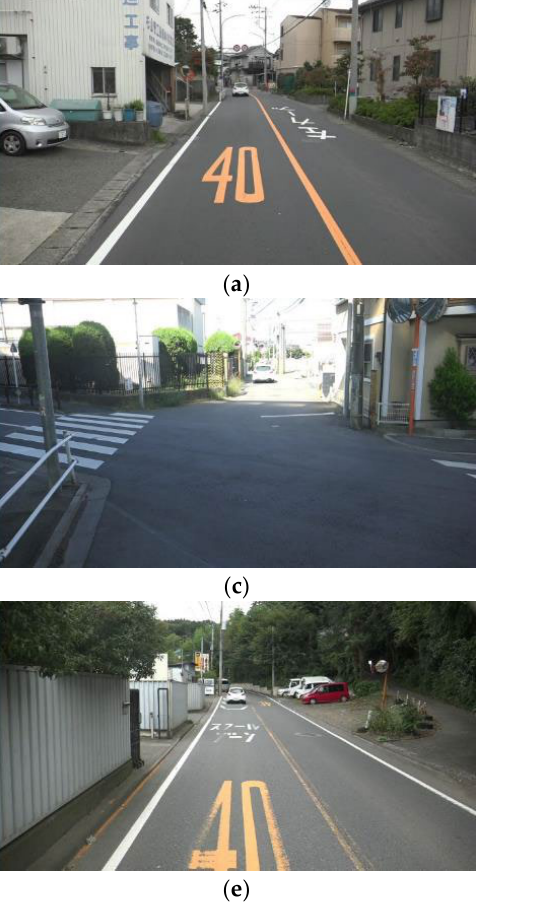
Figure 1. Some examples of road markings on road surfaces: ( a ) white solid, maximum speed limit 40, yellow solid, and left-curve notice (ordinary); ( b ) stop notice and stop line (shadow); ( c ) pedestrian crossing and stop line (dazzle light); ( d ) white solid, yellow solid, turn-right notice, and straight notice (occlusion); ( e ) white solid, maximum speed limit 40, school-zone notice, slow-down marking, and yellow solid (deteriorated road markings); ( f ) white solid, slow-down notice, stop notice, stop line, and +-shaped road intersection (narrow road).